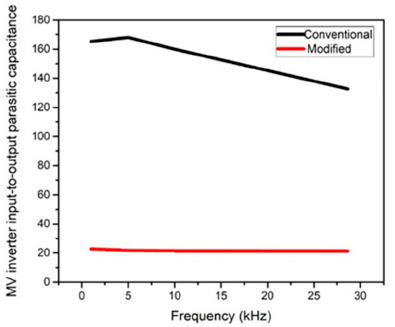
Figure 11. Toroidal transformers at 180 ◦ sectored winding, parasitic coupling capacitance comparison